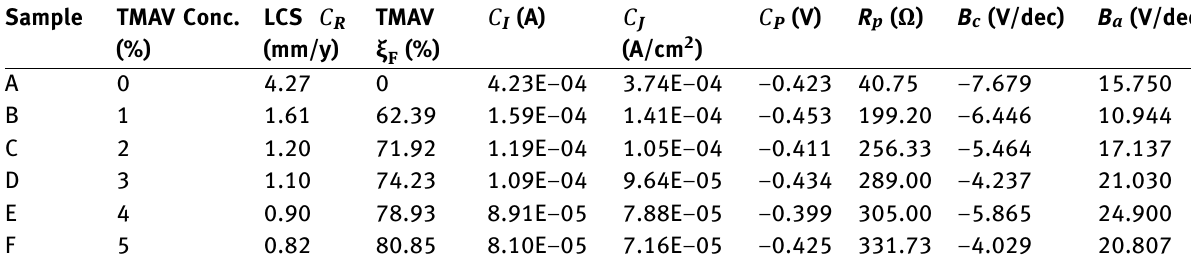
Table 2: Potentiodynamic polarization data for LCS corrosion in 1 M H 2 SO 4 at specific TMAV concentration Sample